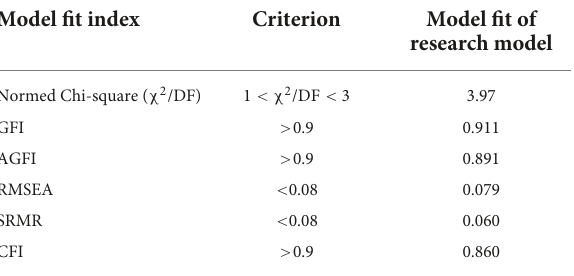
TABLE 5 Results of goodness-of-fit indices of the model. Model fit